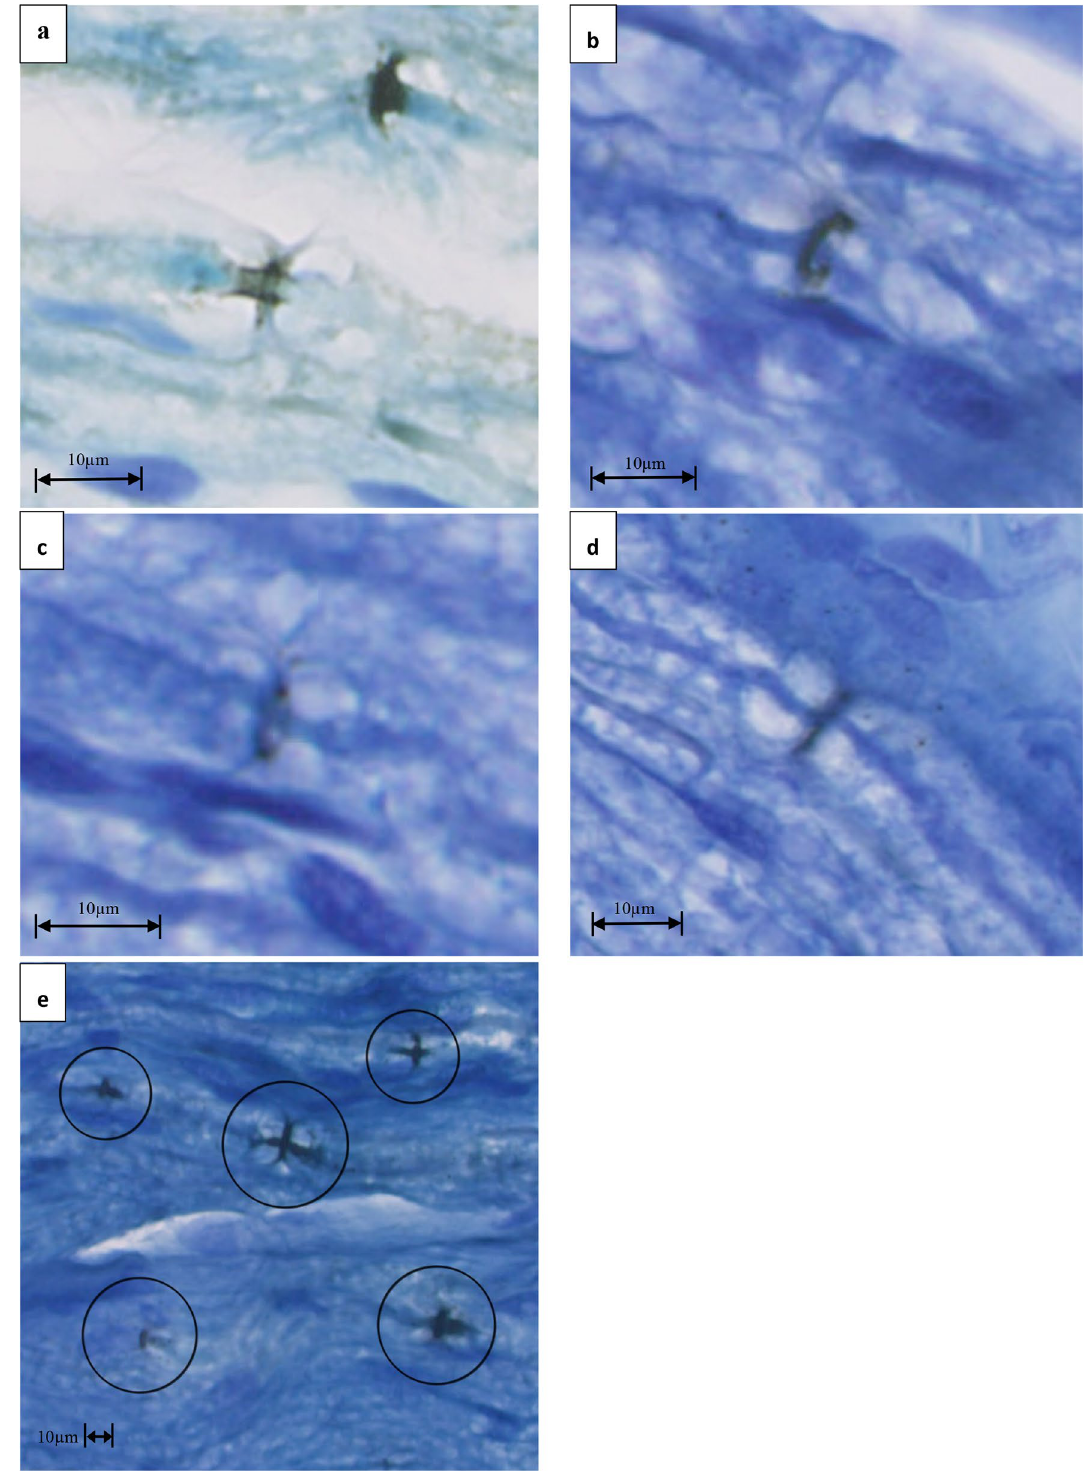
Figure 1. Examples of nodes where Ag deposited after electrical stimulation of rat sciatic nerves. In ( a – d ) a zoom of some annular Ag depositions in the nodes are displayed. Circles in ( e ) put in evidence Ag deposition in the nodes and along paranodal